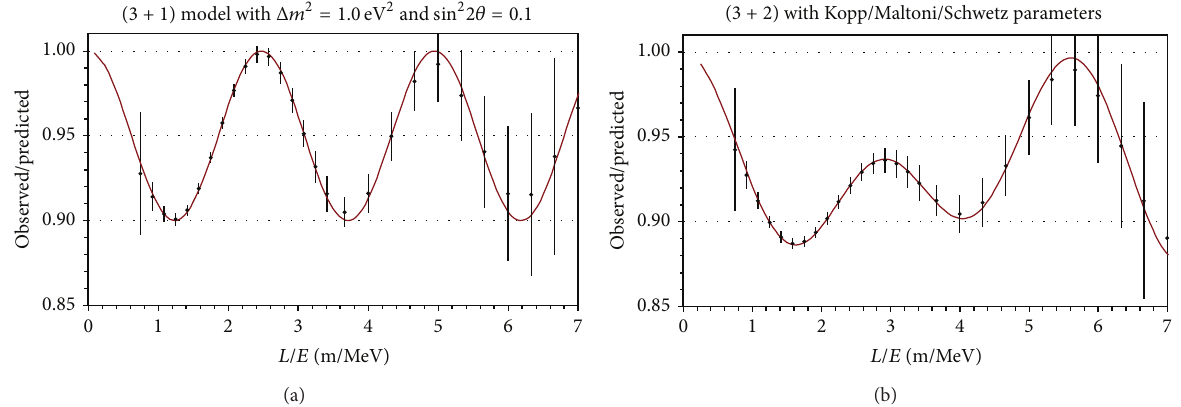
Figure 7: Example data sets for 5 years of running for 3 + 1 (a) and 3 + 2 (b) oscillation scenarios.